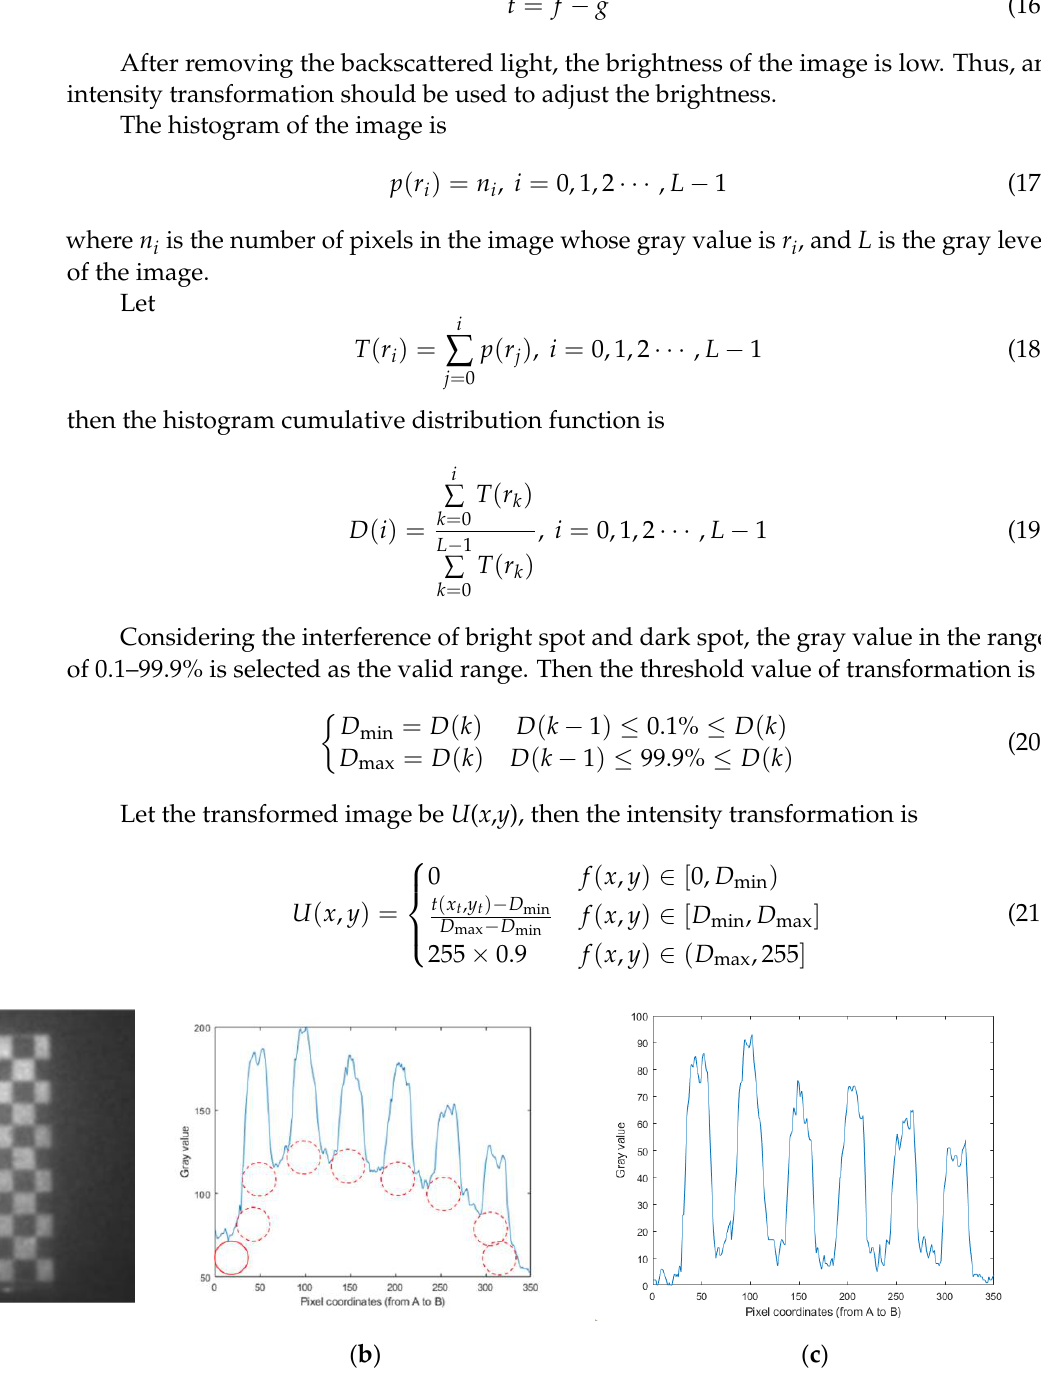
Figure 4. Description of rolling ball background subtraction algorithm: ( a ) underwater image captured by PLRGI system; ( b ) calculated background of line A-B by rolling ball; ( c ) corrected profile.